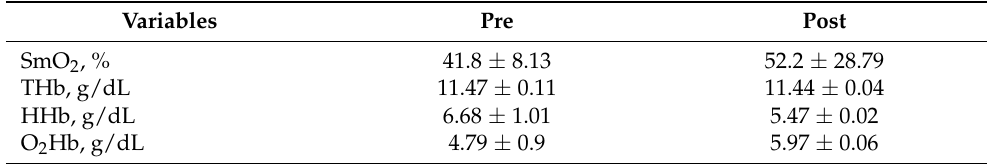
Table 2. Muscle oxygen values before and after the intervention.